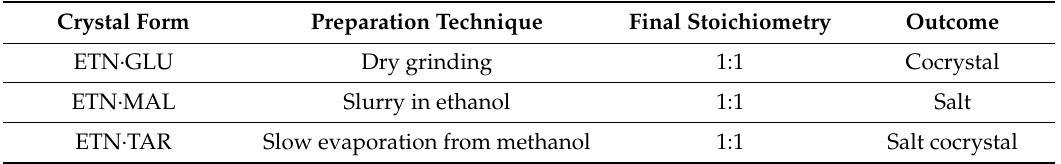
Table 2. Summary of the employed techniques used for the solid-state preparations, with final stoichiometry and ionization state for all obtained